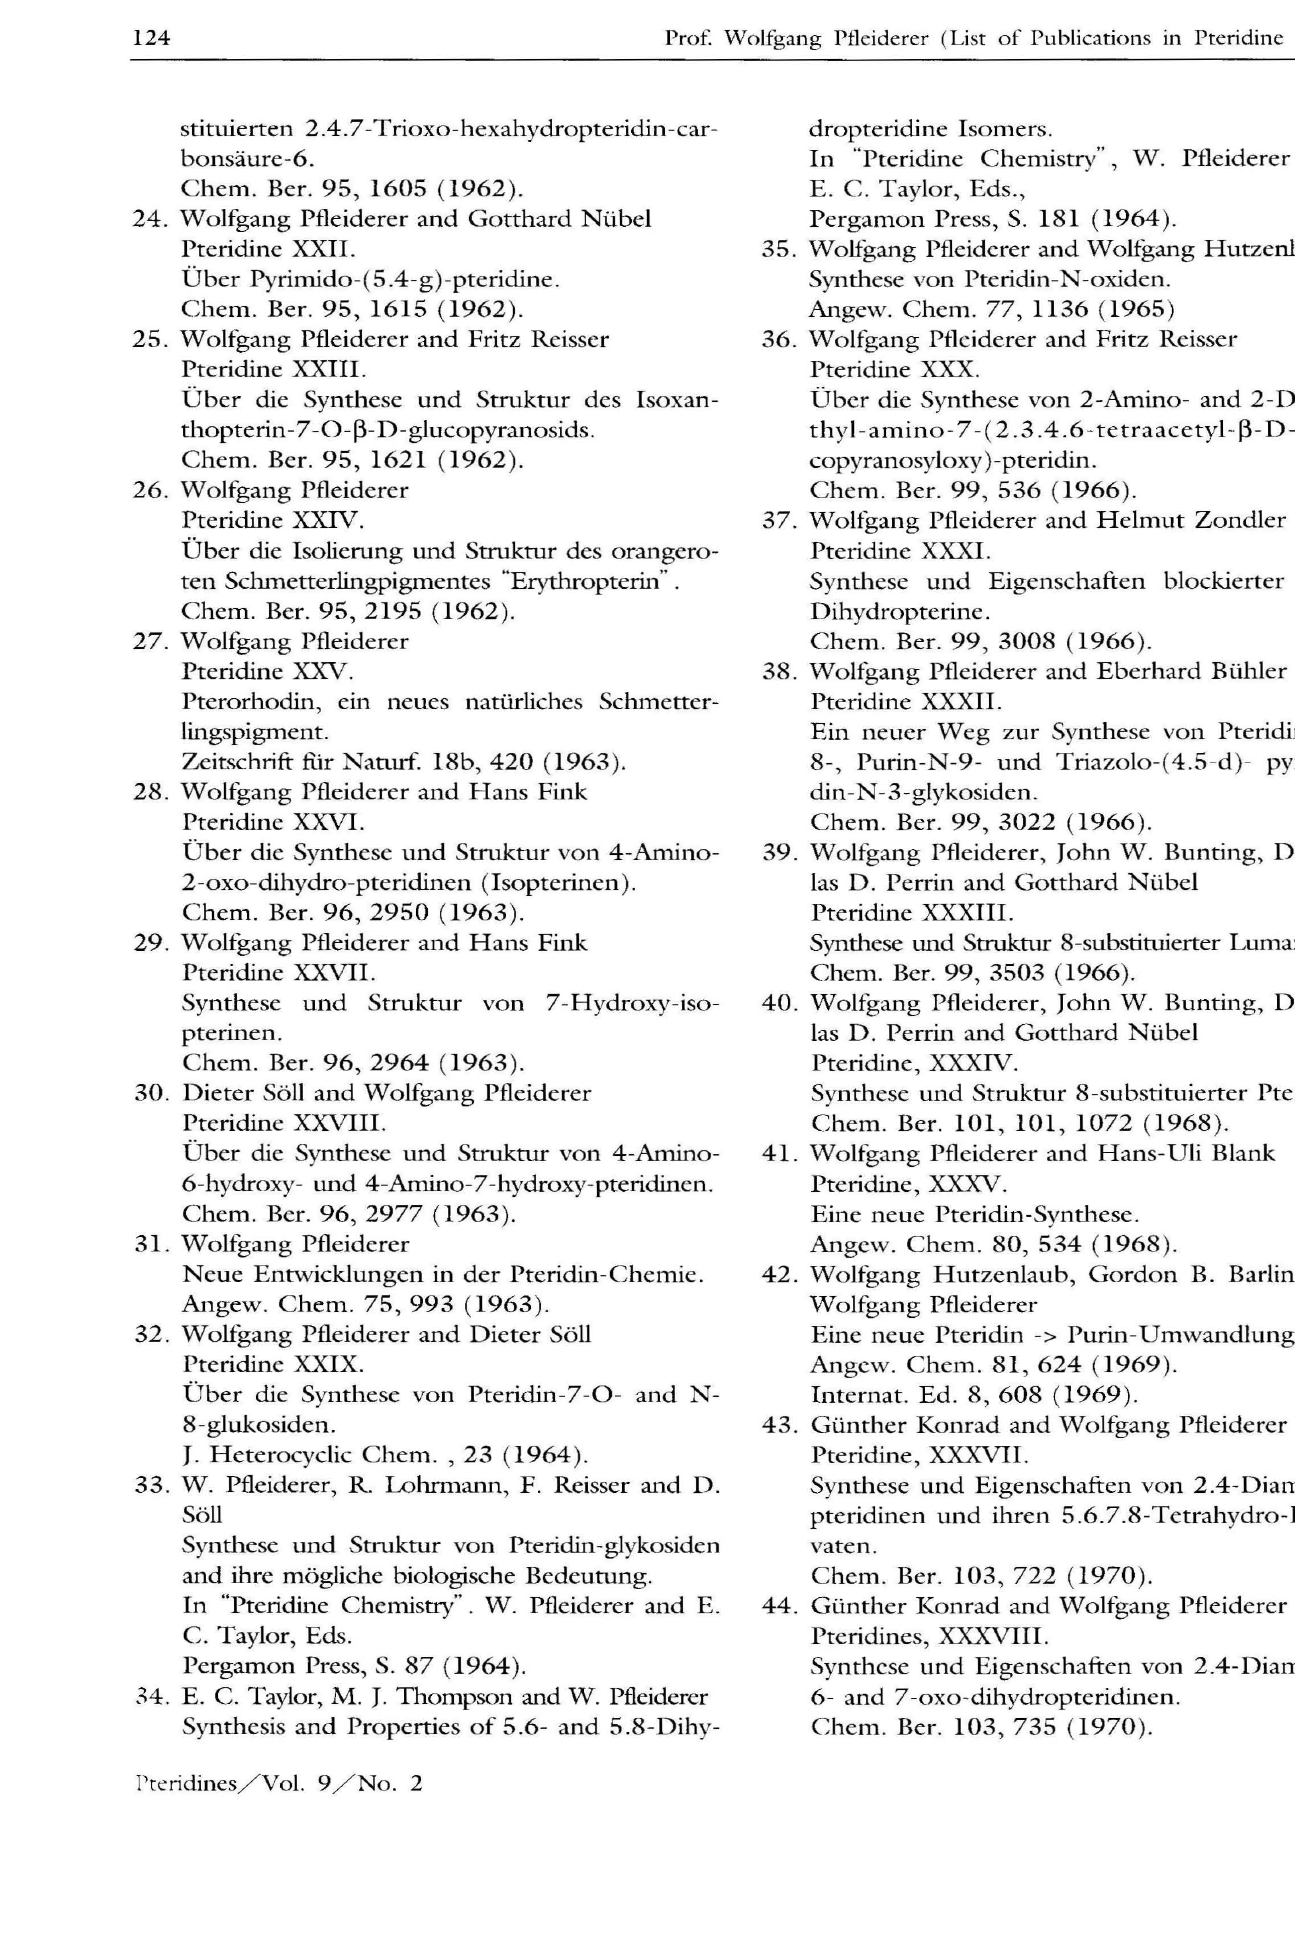
stituierten 2.4.7-T rioxo-hexahydropteridin -car bonsaure-6